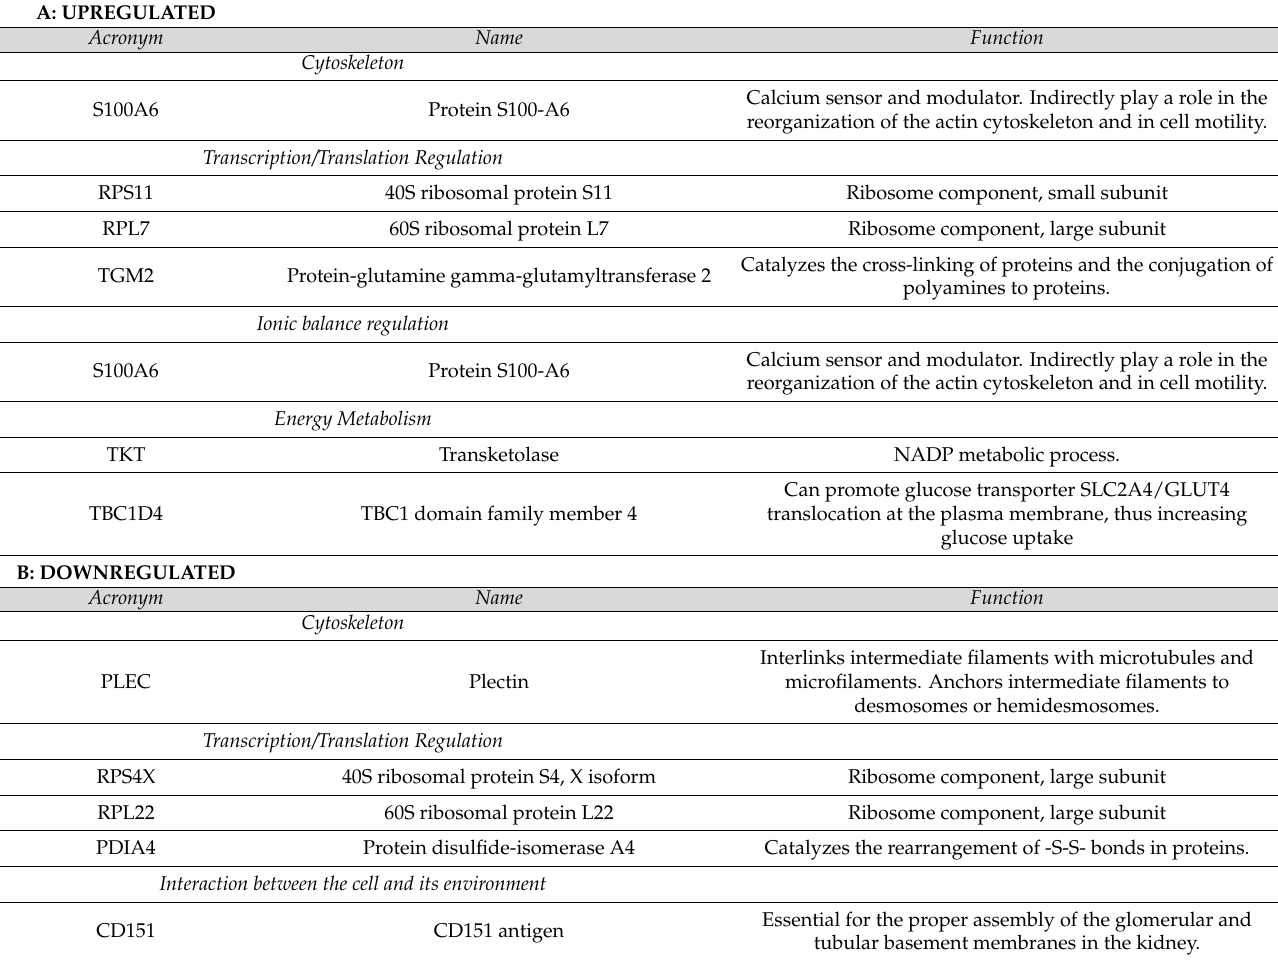
Table 3. Proteins which expression was altered between H3 and